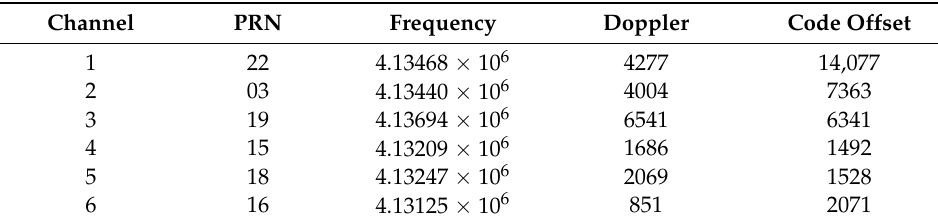
Table 3. PRNs of Dataset 2.